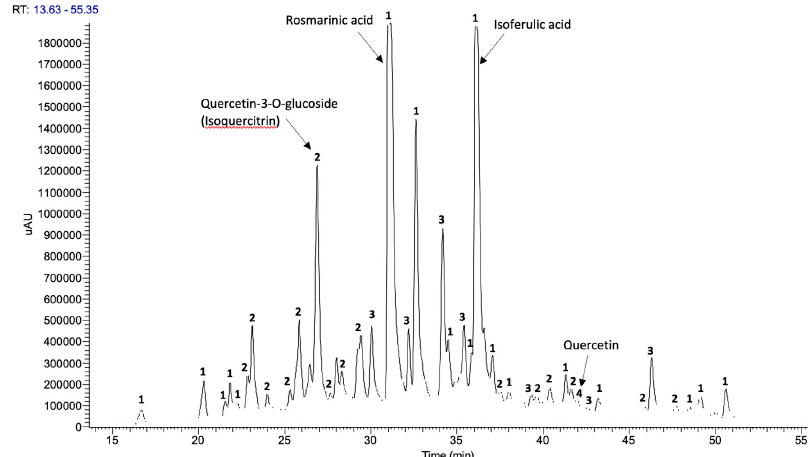
Figure 1. Phenolic profile of Summer Savory extract determined by HPL-DAD with selective detection at 320 nm, including identification of functional groups (main components). Legend: 1. hydroxycinnamic acids, 2. flavonol glycosides, 3. flavones and flavonones, 4. Flavonols.